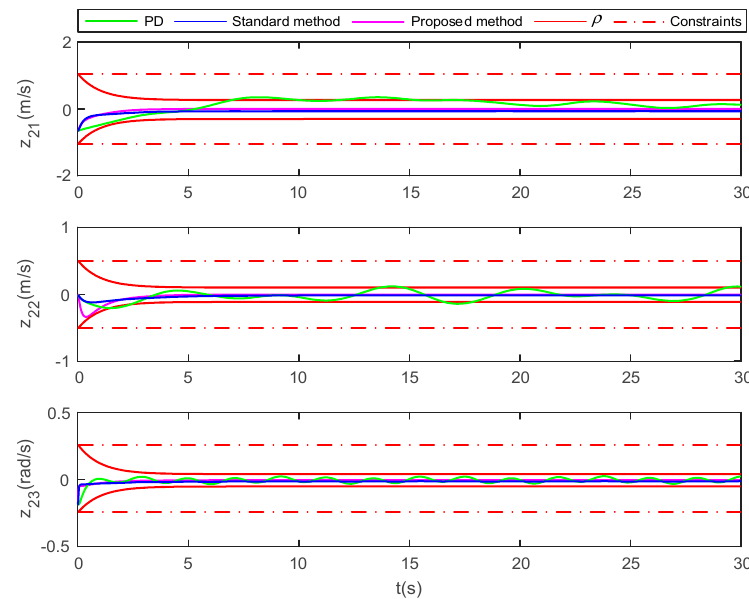
Figure 7. Velocity tracking error of the vessel under three control methods. Figure 5 shows the pose tracking error of the vessel under the three control methods. From the figure, it can be seen that when the set time T f = 4 s, the pro- posed enables the pose tracking error to converge quickly in finite-time and satisfies the transient and steady-state performance and does not violate the preset constraints K b 1 , while the standard backstepping method and PD control method cannot ensure that each pose tracking error quickly converges to the prescribed